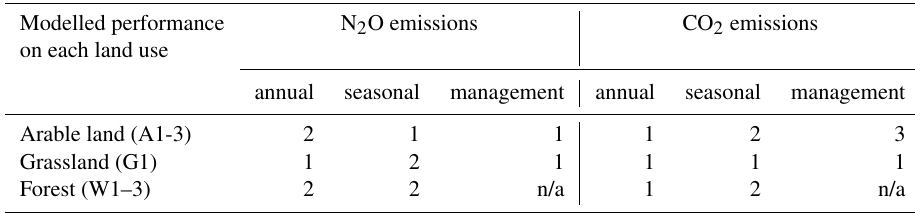
Table 6. Overall posterior model performance of LandscapeDNDC on different land uses in reproducing GHG emission data. Subjectively classified into (1) good, (2) medium and (3) poor model performance in simulating reliable annual sums, seasonal patterns and magnitudes of management events (e.g. fertilizer